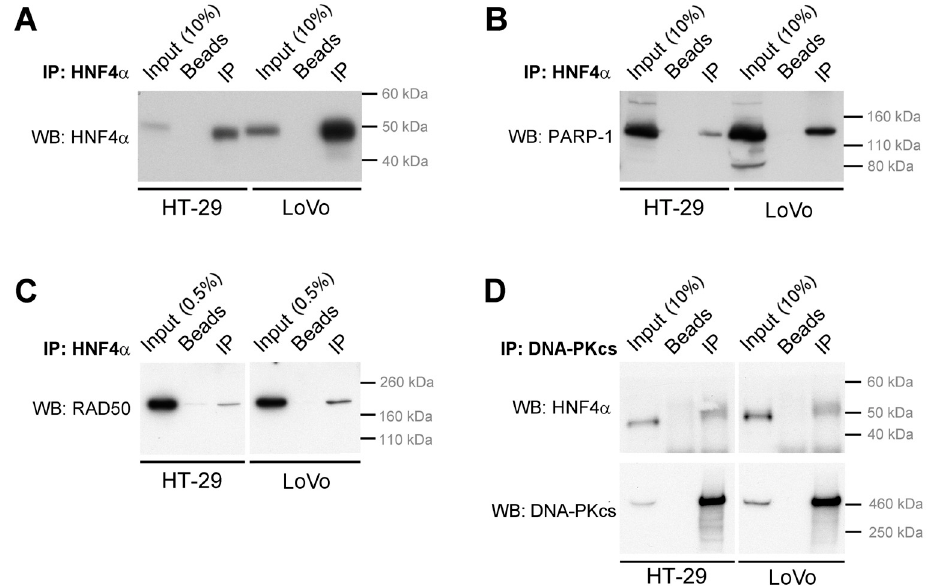
Figure 5. DNA repair proteins co-immunoprecipitate with endogenous HNF4 α in colorectal cancer cells. Total protein extracts were isolated from HT-29 and LoVo colorectal cancer cell lines, and HNF4 α ( A – C ) or DNA-PKcs ( D ) were immunoprecipitated using specific antibodies. Following immunoprecipitation, the specific enrichment of HNF4 α , PARP-1, RAD50, or DNA-PKcs in the immunoprecipitate was verified by Western blot. In both cell lines, PARP-1, RAD50, DNA-PKcs were detected as proteins co-immunoprecipitated along with HNF4 α . Incubation of protein extracts with beads alone served as control for the immunoprecipitation.